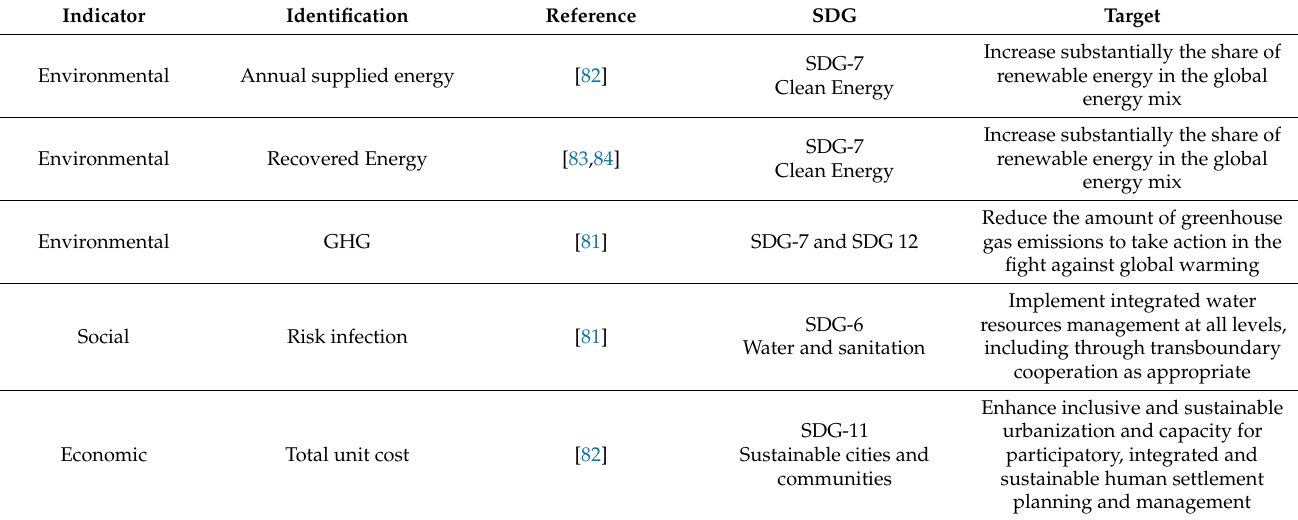
Table 3. Indicators vs. measured